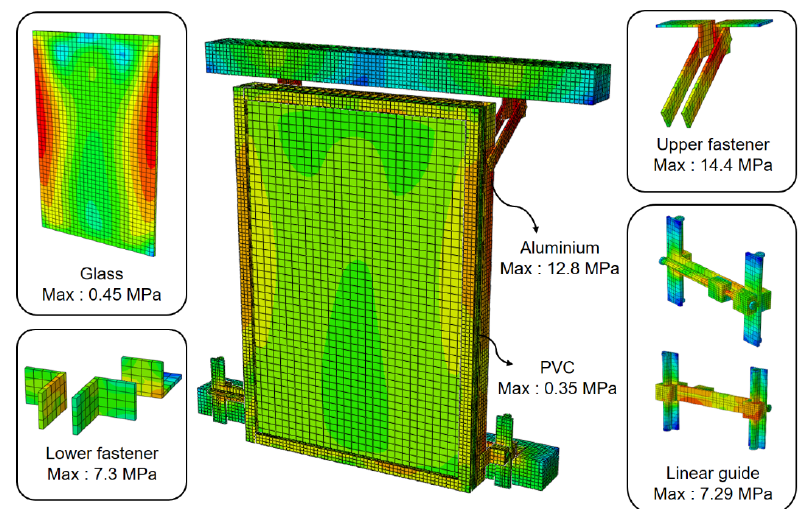
Figure 29. Seismic curtain wall deformation: linear guide length 150 mm.